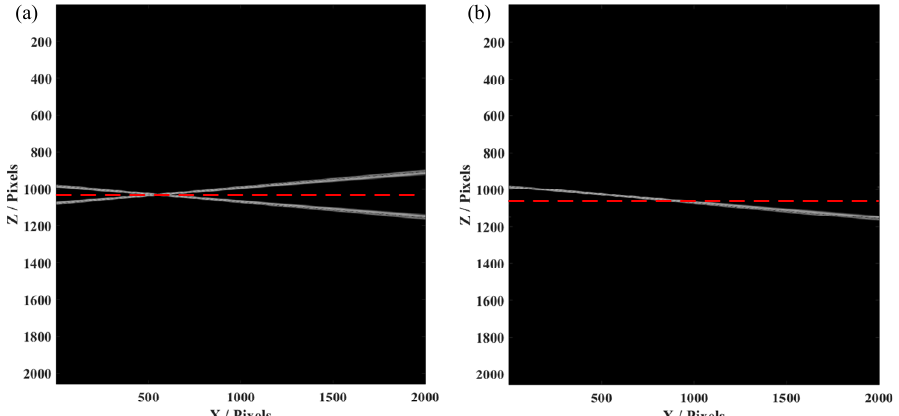
Figure 2. The simulation results of a single-layer structure by FROCT using a voice coil motor. ( a ) The conventional OCT image with conjugate artifacts. ( b ) The FROCT B-scan image recovered by our proposed method, is free of mirror artifacts. The red dashed line is the position of zero-phase delay. The simulated spectrometer has 2048 pixels and the value of “1024” in Y axis means the zero-phase delay position in the constructed B-scan.